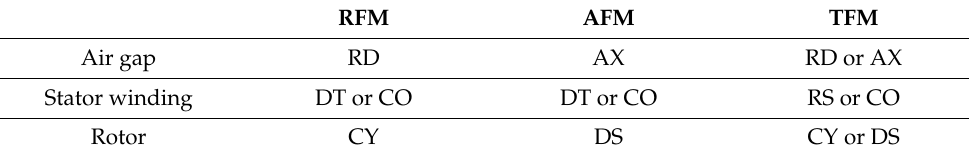
Table 1. Air gap, stator winding and rotor of RFMs, AFMs and TFMs.